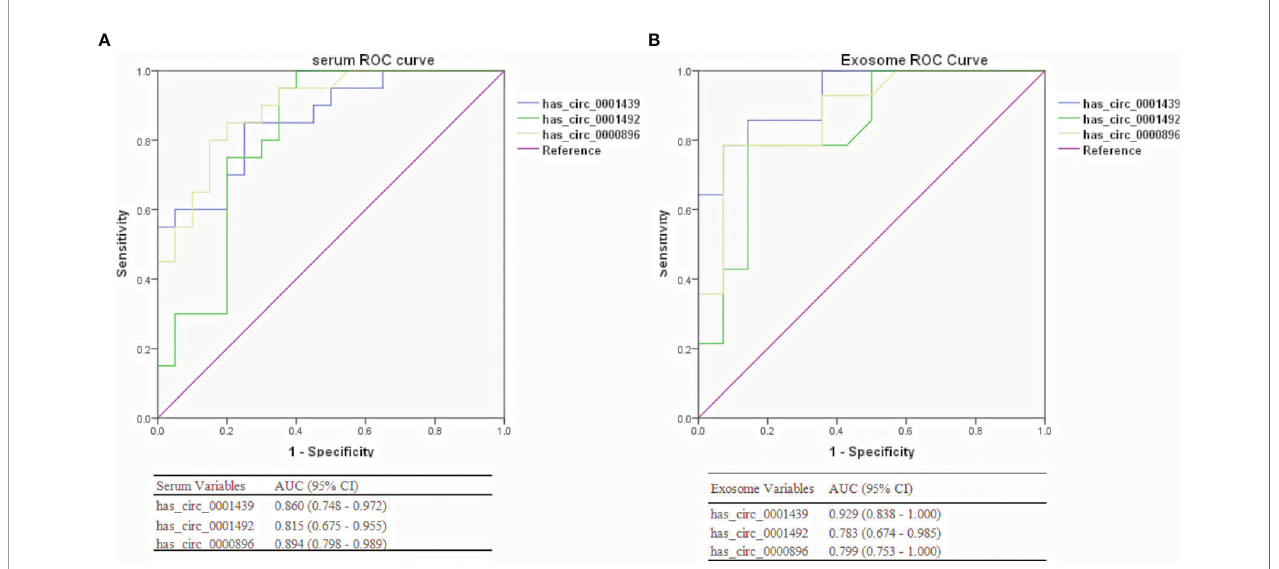
FIGURE 5 | Diagnostic performances of serum (A) and serum exosomal (B) circRNAs in preoperative and postoperative LUAD